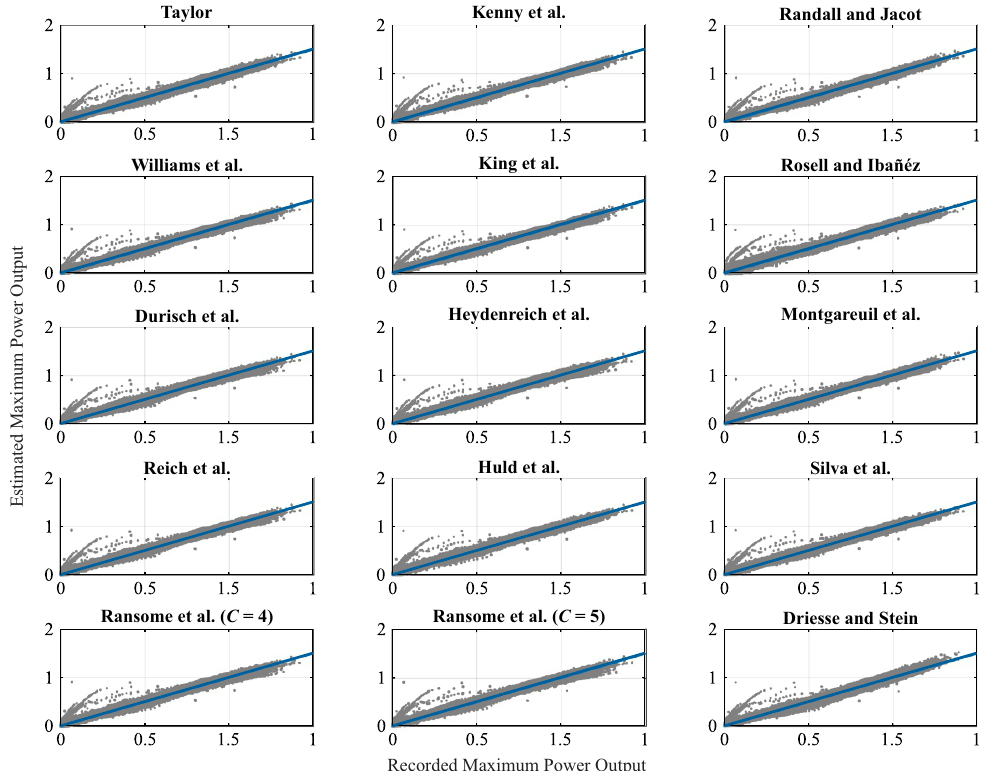
Figure 4. Maximum power output estimated by the empirical models versus those recorded for the PV modules under study. Both are normalized concerning the respective rated powers of the PV modules.